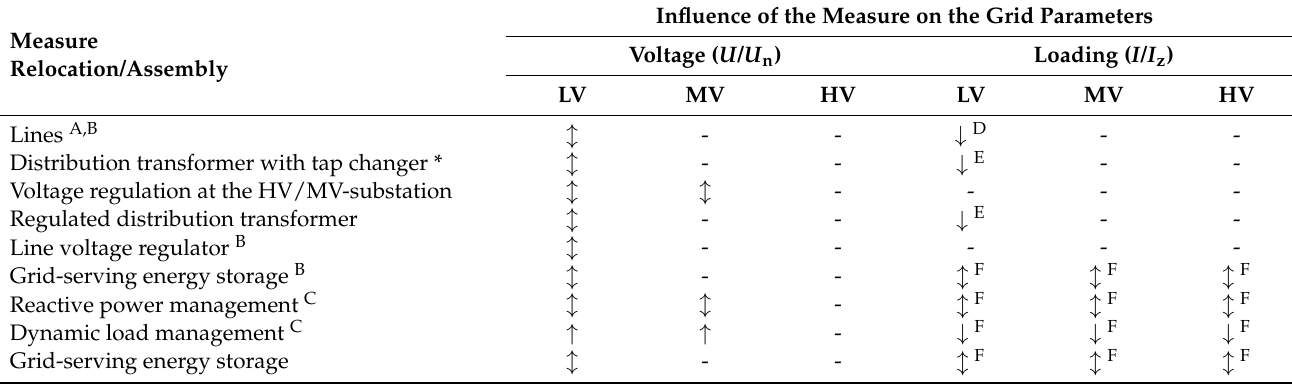
Table 5. Overview of the effects of innovative equipment and technologies on the various voltage levels when used in or for the low-voltage level as well as for complementary conventional measures based on